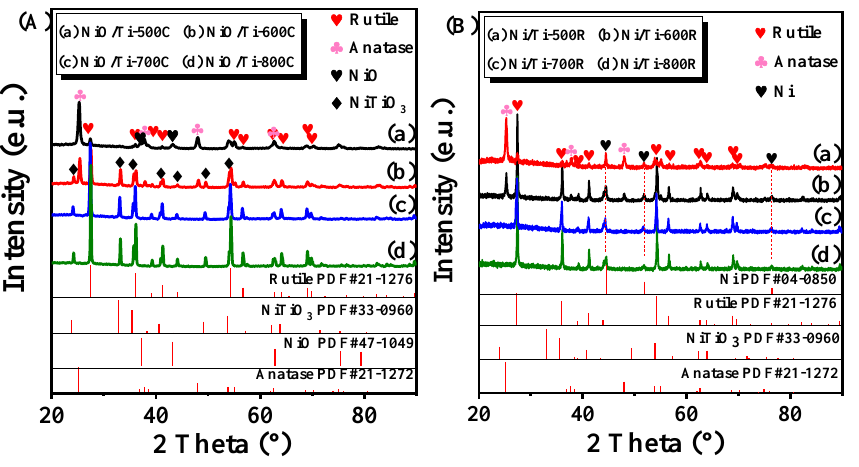
Figure 2. XRD patterns of the ( A ) calcined and ( B ) reduced catalysts. Table 1. Physicochemical parameters for the samples.